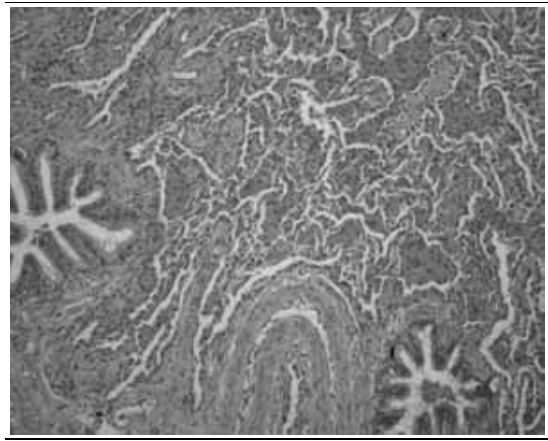
figurE 4 – IPH: hemosiderin-laden macrophages filling alveolar spaces, without evidence of vasculitis in small blood vessels and in alveolar septa (HE 100×) IPH: idiopathic pulmonary hemorrhage; HE: hematoxylin and eosin.